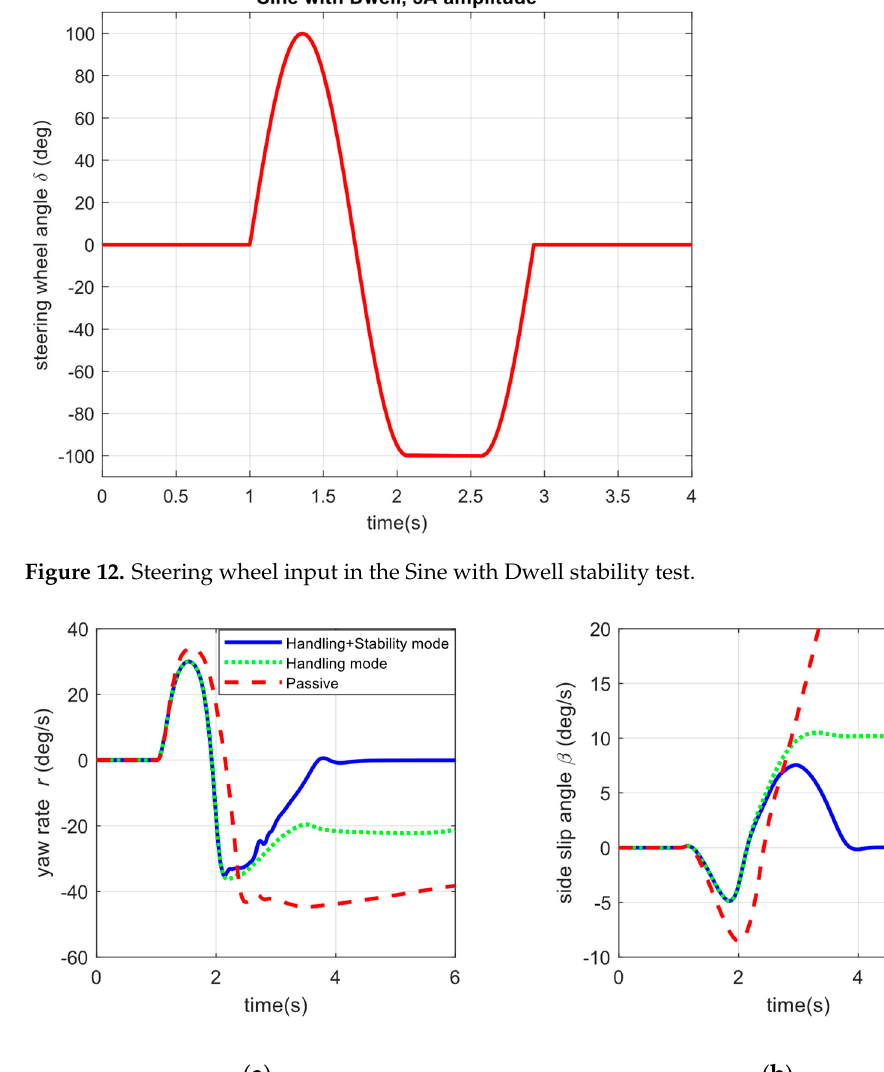
15 of 19 Figure 11. Results in the steering ramp test: ( a ) Lateral acceleration vs. steering wheel angle input; ( b ) Lateral acceleration vs. side slip angle.